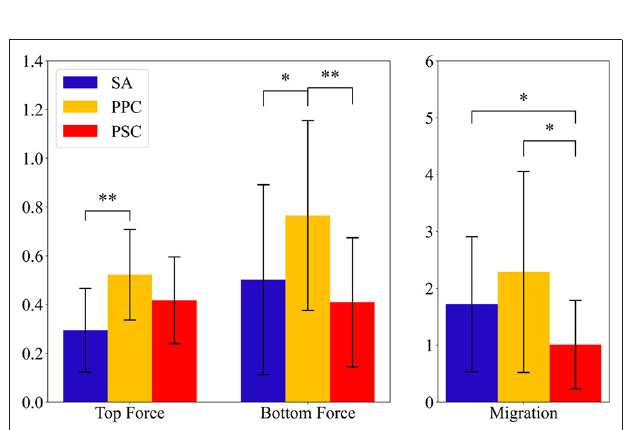
FIGURE 7 | (A) Average knee moments for all four braces. The shaded region represented 1 SD. (B) Average peak knee moment for all braces. The ticks represent 1 SD.